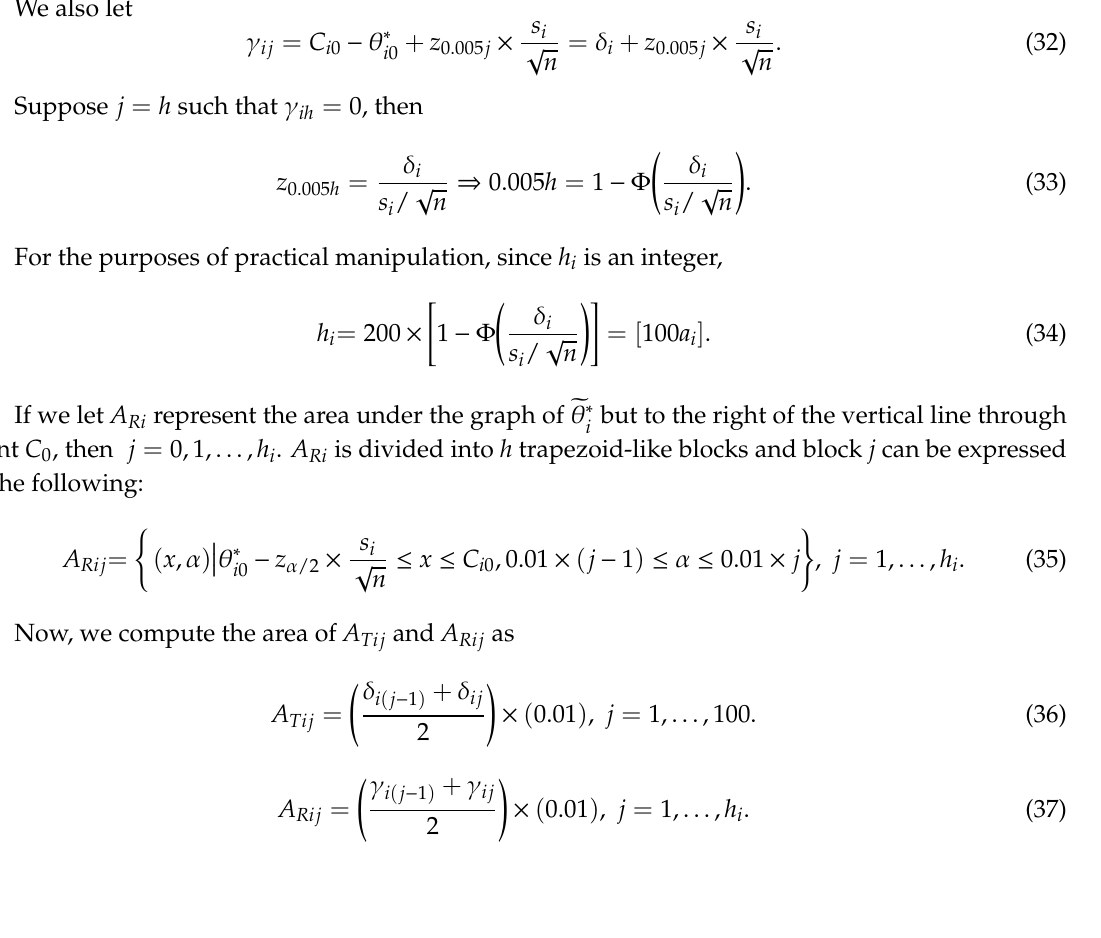
( ) x η . Figure 1. Membership functions of η i ( x ) and η 0 ( x ) 0